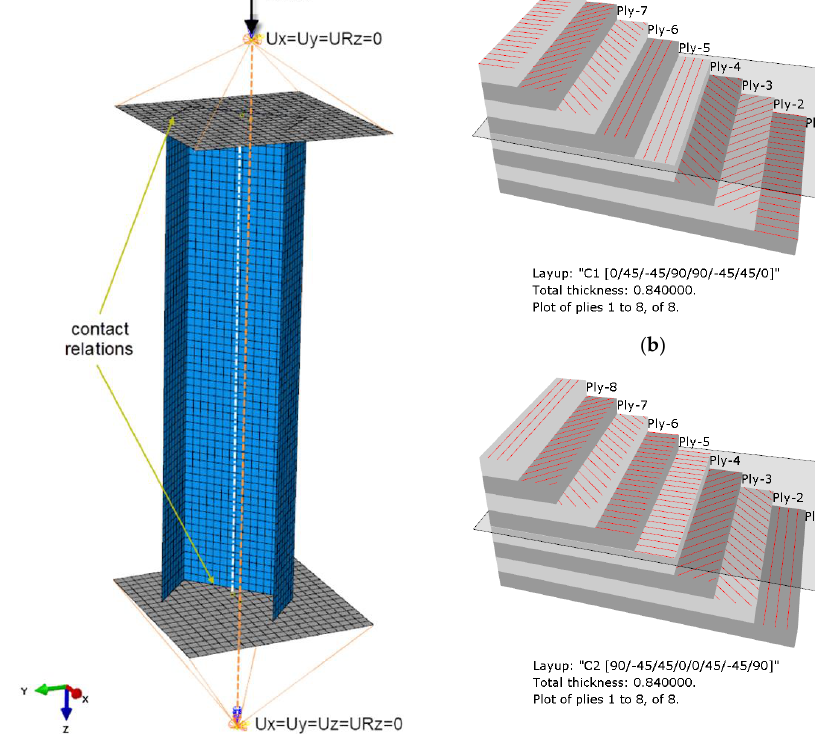
Figure 5. FEM analysis: ( a ) discrete model of a column and the boundary conditions for the eccentricity value of e10mm_45, ( b ) layup C1, ( c ) layup C2.